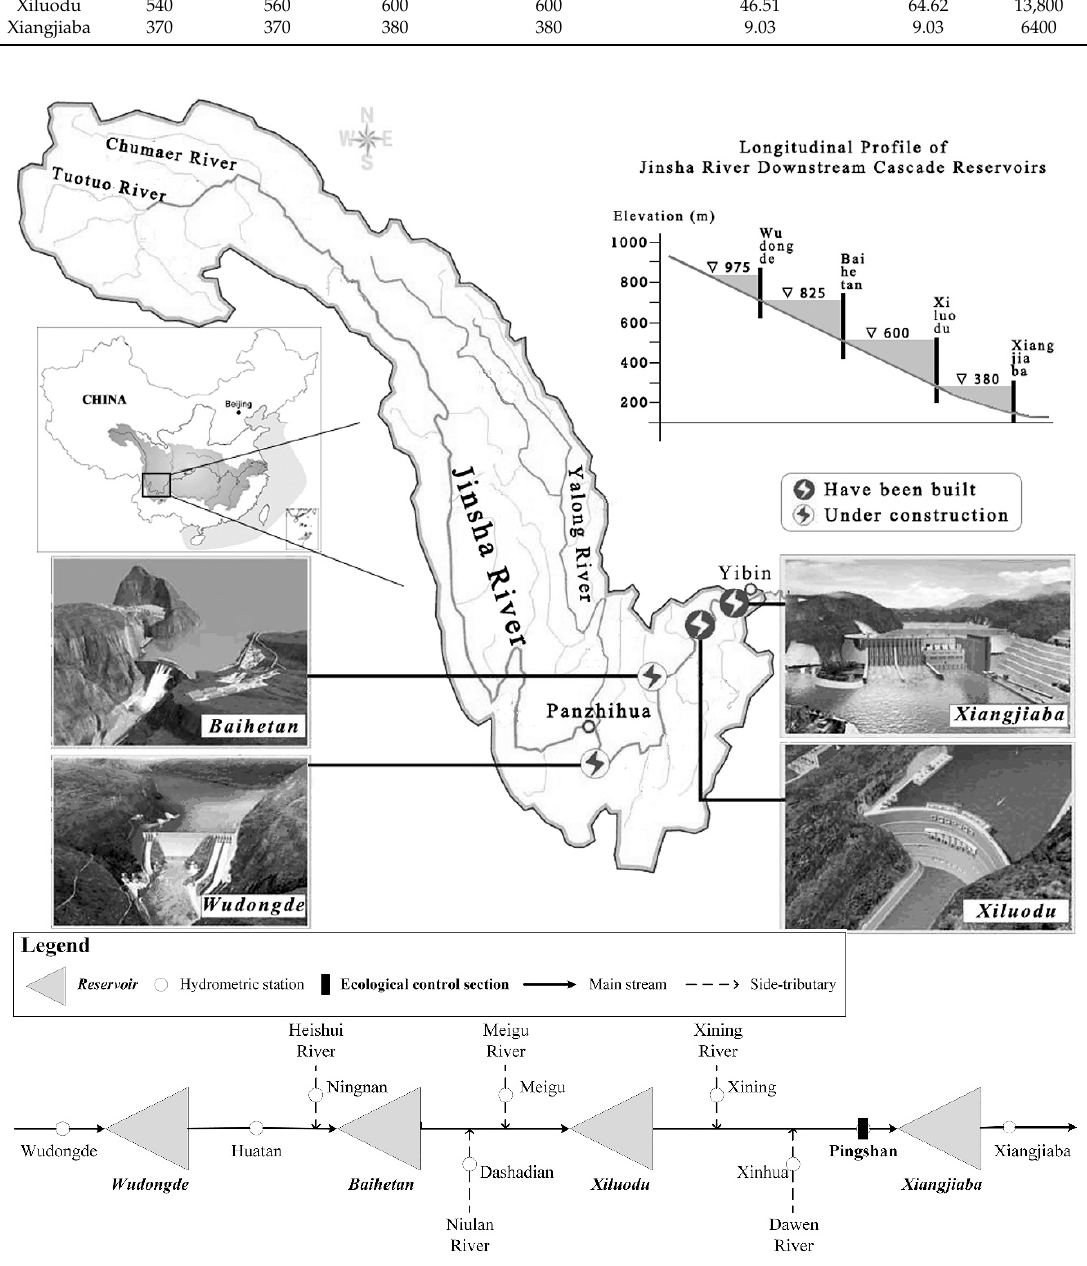
Figure 1. The schematic diagram of the Jinsha River downstream cascade reservoirs.